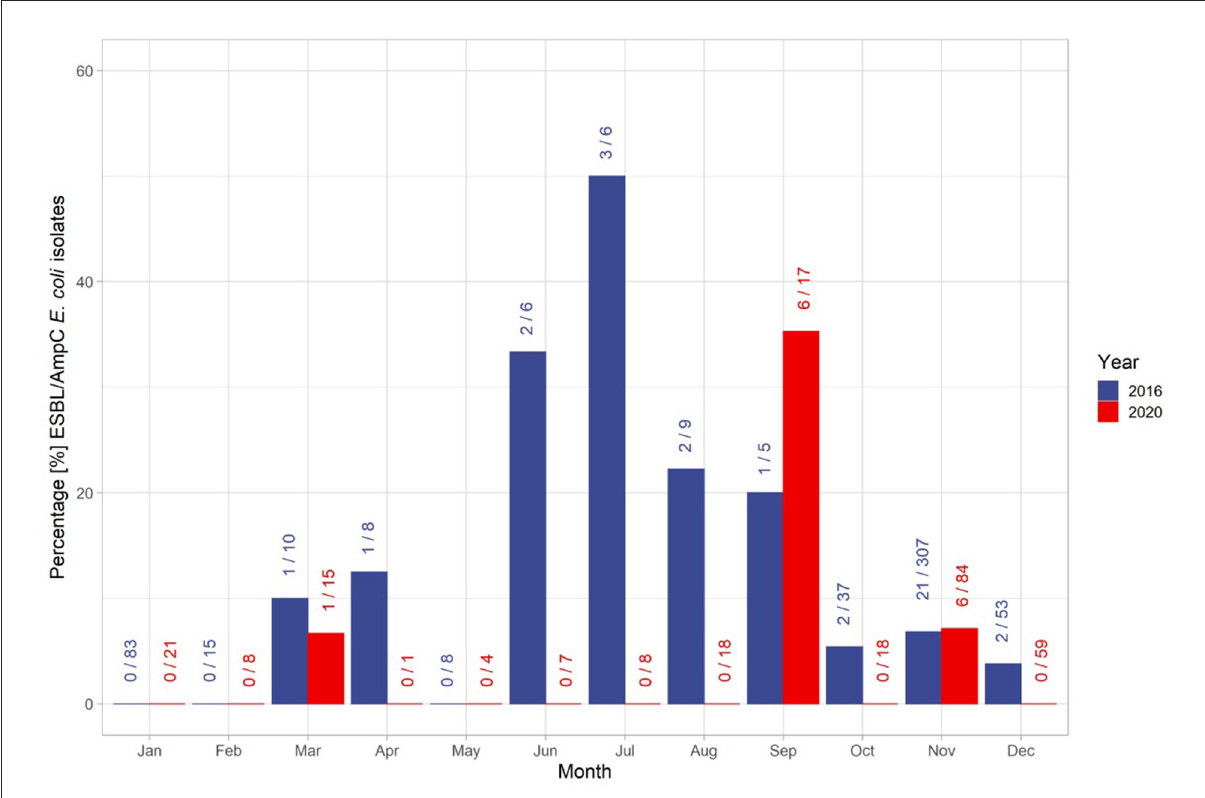
FIGURE3 Distribution of isolates and the total number of samples throughout the years 2016 and 2020. The first number at each bar represent the number of identified ESBL/AmpC E. coli isolates within the month, and the second number after the slash sign represents the total number of samples taken within the month. The colors of the bars and numbers represent the associated